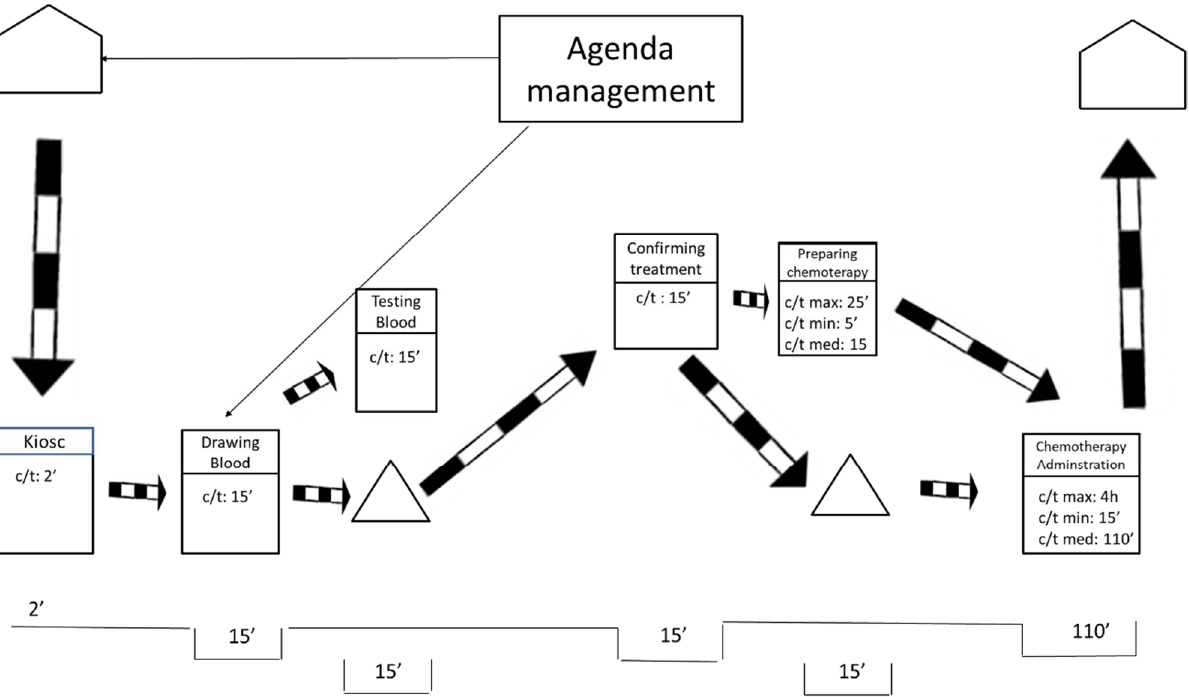
Figure 5. Ideal future state map.